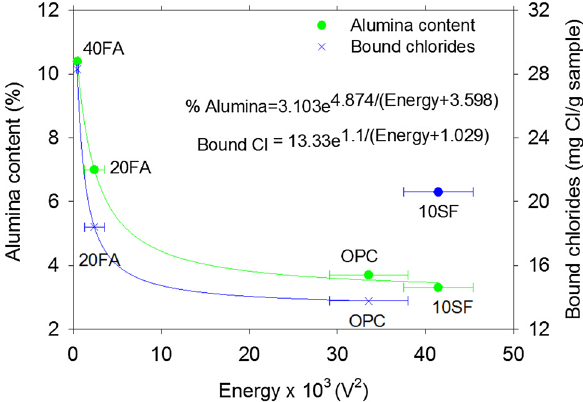
Fig. 13 Amplitude weighted average frequencies obtained from the Fourier spectra of ultrasonic response signals and the chloride binding capacities of the cement pastes (data correspond to pastes 14 days after vacuum saturation with a 2.8 mol/L NaCl solution).